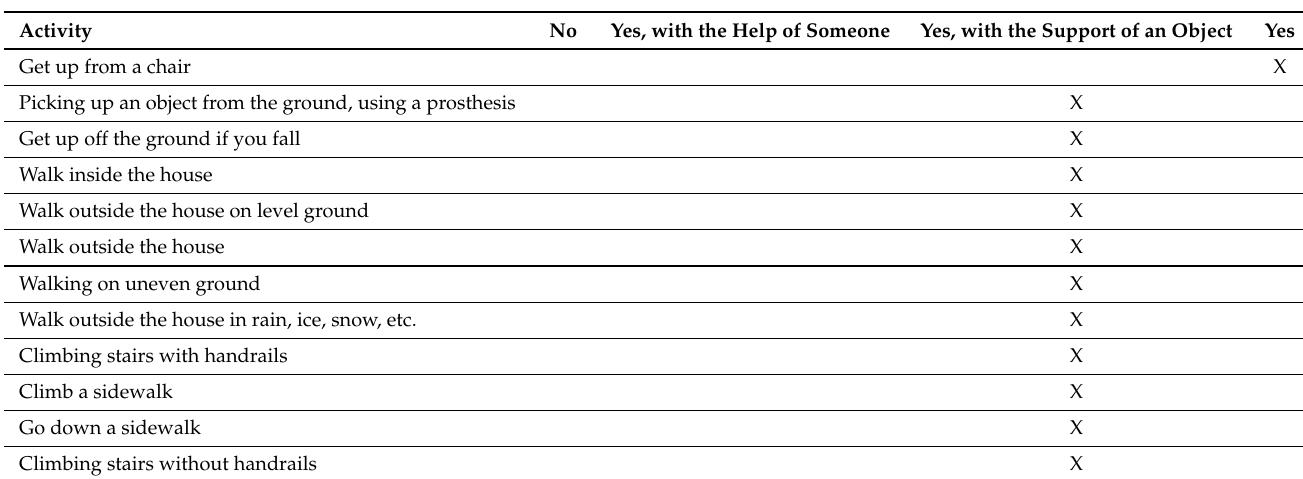
Table A3. Motor capacity index.